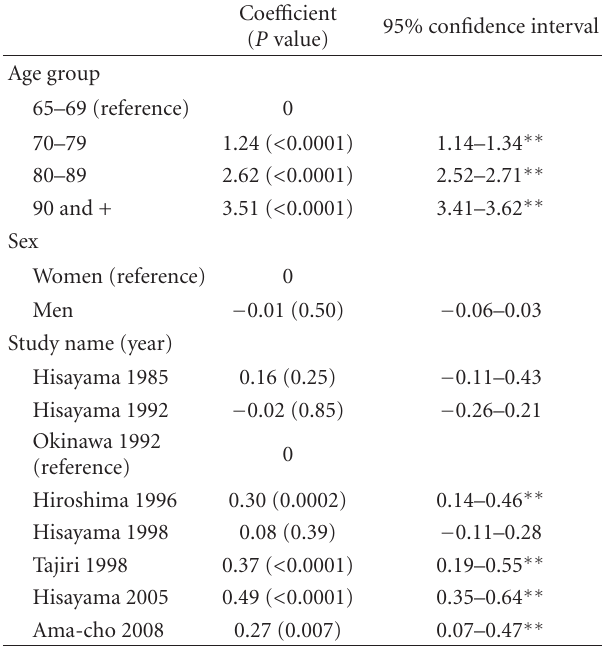
Table 2: Factors associated with all-cause dementia